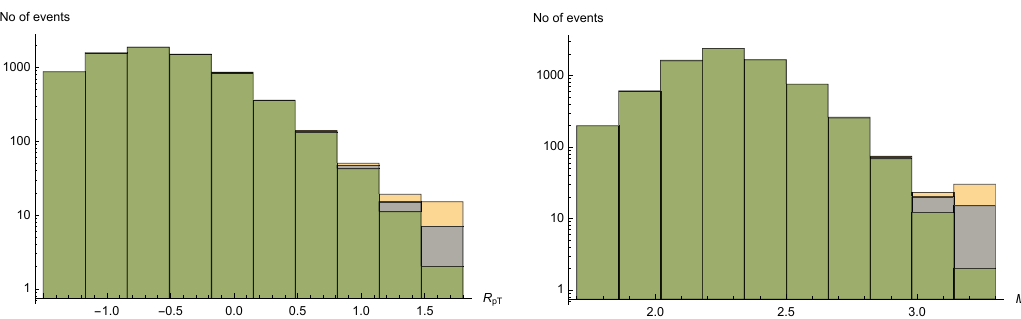
Figure 1 . Examples of kinematic distributions used for the assessment of BSM signal significances. Shown are the distributions R in yellow corresponds to the operators treatment according to eq. (1.8); the region in gray corresponds to the operator 0 . 1 TeV − 4 and the high- M and an integrated luminosity of 3 ab − 1 are